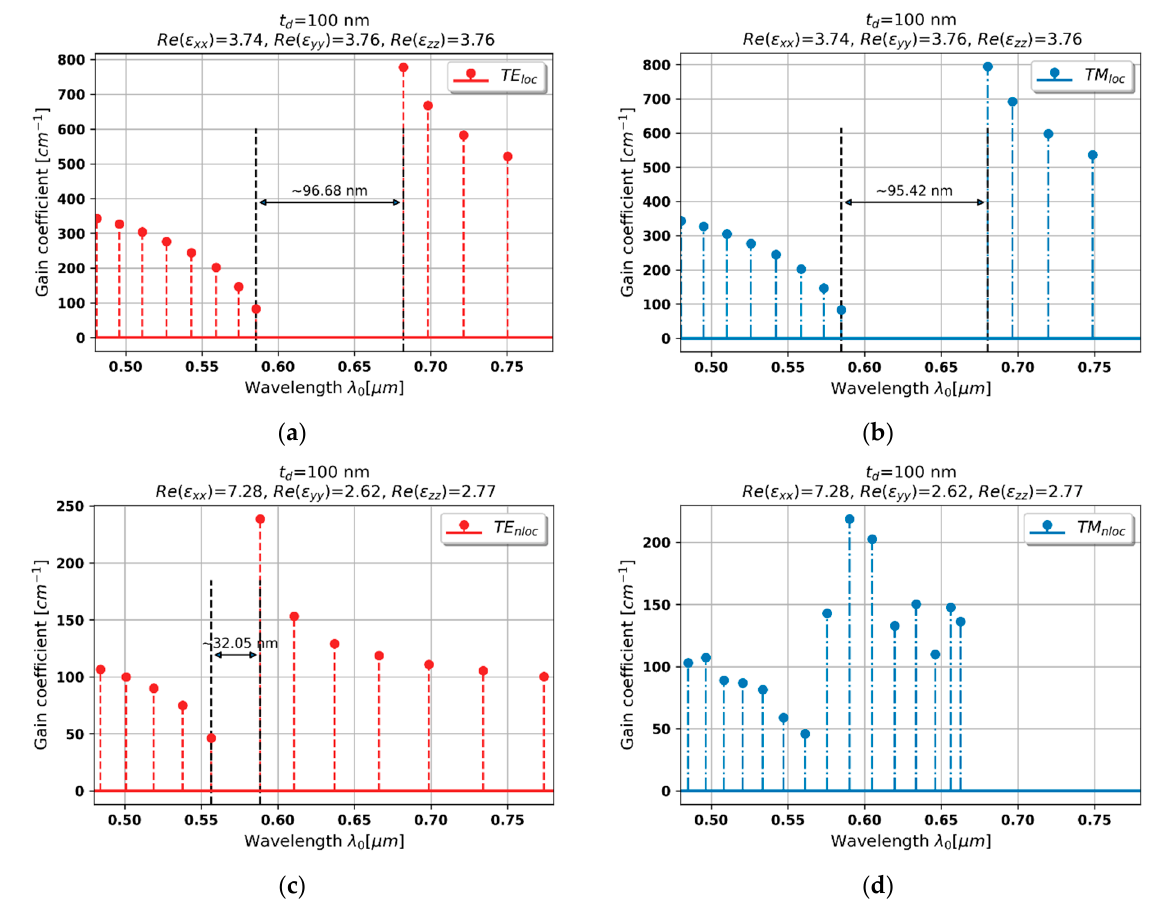
Figure 6. Modal spectra for TE ( a , c ) and TM-polarized light ( b , d ) for a PHC laser based on hyperbolic medium with t ZnO = 100 nm dielectric layer (black double-headed arrow denotes spectral width of stop band of the